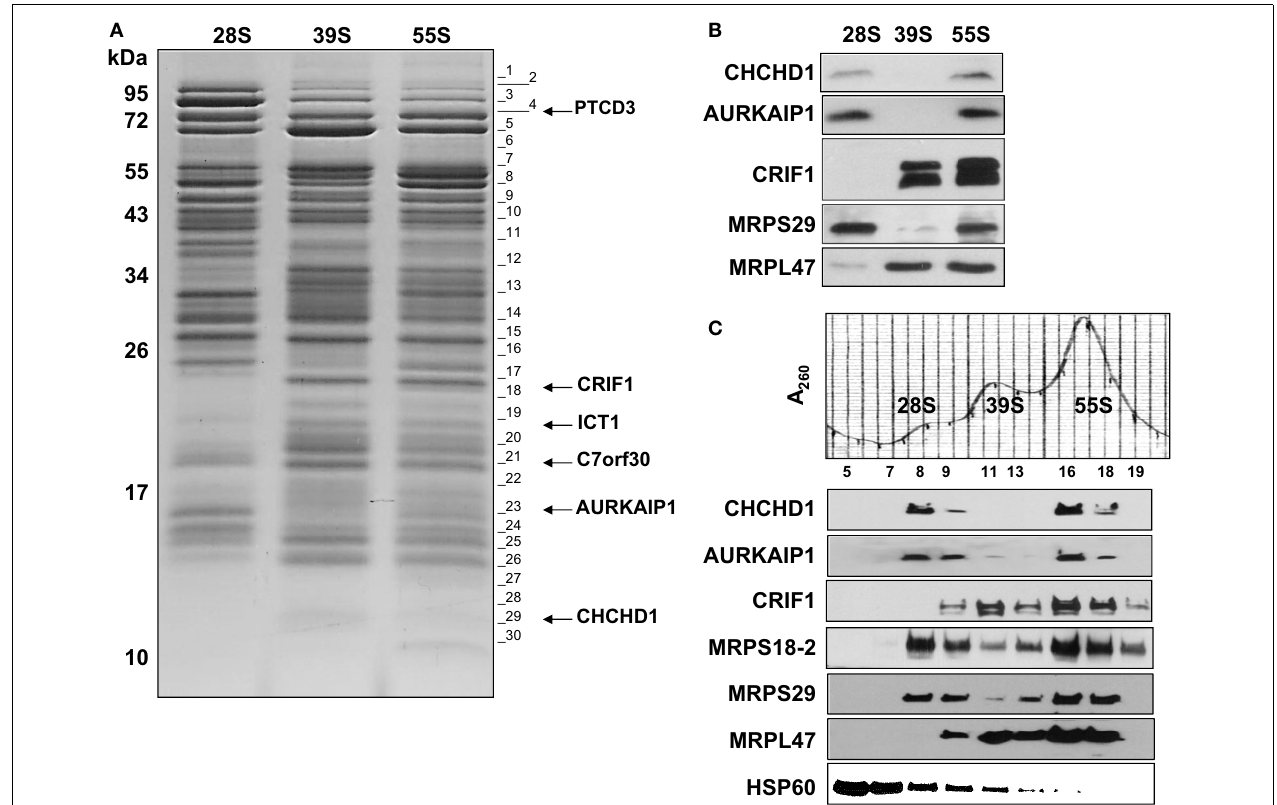
from the dissociation of purified 55S ribosomes as described in Materials and Methods at 2mM Mg 2 + . Proteins present in these preparations were separated on 12% SDS-PAGE and analyzed by immunoblotting using CHCHD1, AURKAIP1, CRIF1, MRPS29, and MRPL47 antibodies to confirm subunit distribution of new MRPs. (C) To confirm the ribosome association of newly identified proteins, crude mitochondrial ribosomes prepared at high salt and detergentconditionswere separated on a 10–30%linear sucrose gradient in the presence of 20mM Mg 2 + as described in Figure 1 . Distribution of new proteins, CHCHD1, AURKAIP1, and CRIF1, were detected by immunoblotting analyses of sucrose gradient fractions containing dissociated ribosomal subunits (28S and 39S) and 55S ribosomes. Antibodies against two 28S subunit proteins, MRPS18B and MRPS29, and a 39S protein, MRPL47, were used to indicate the locations of the subunits and the 55S